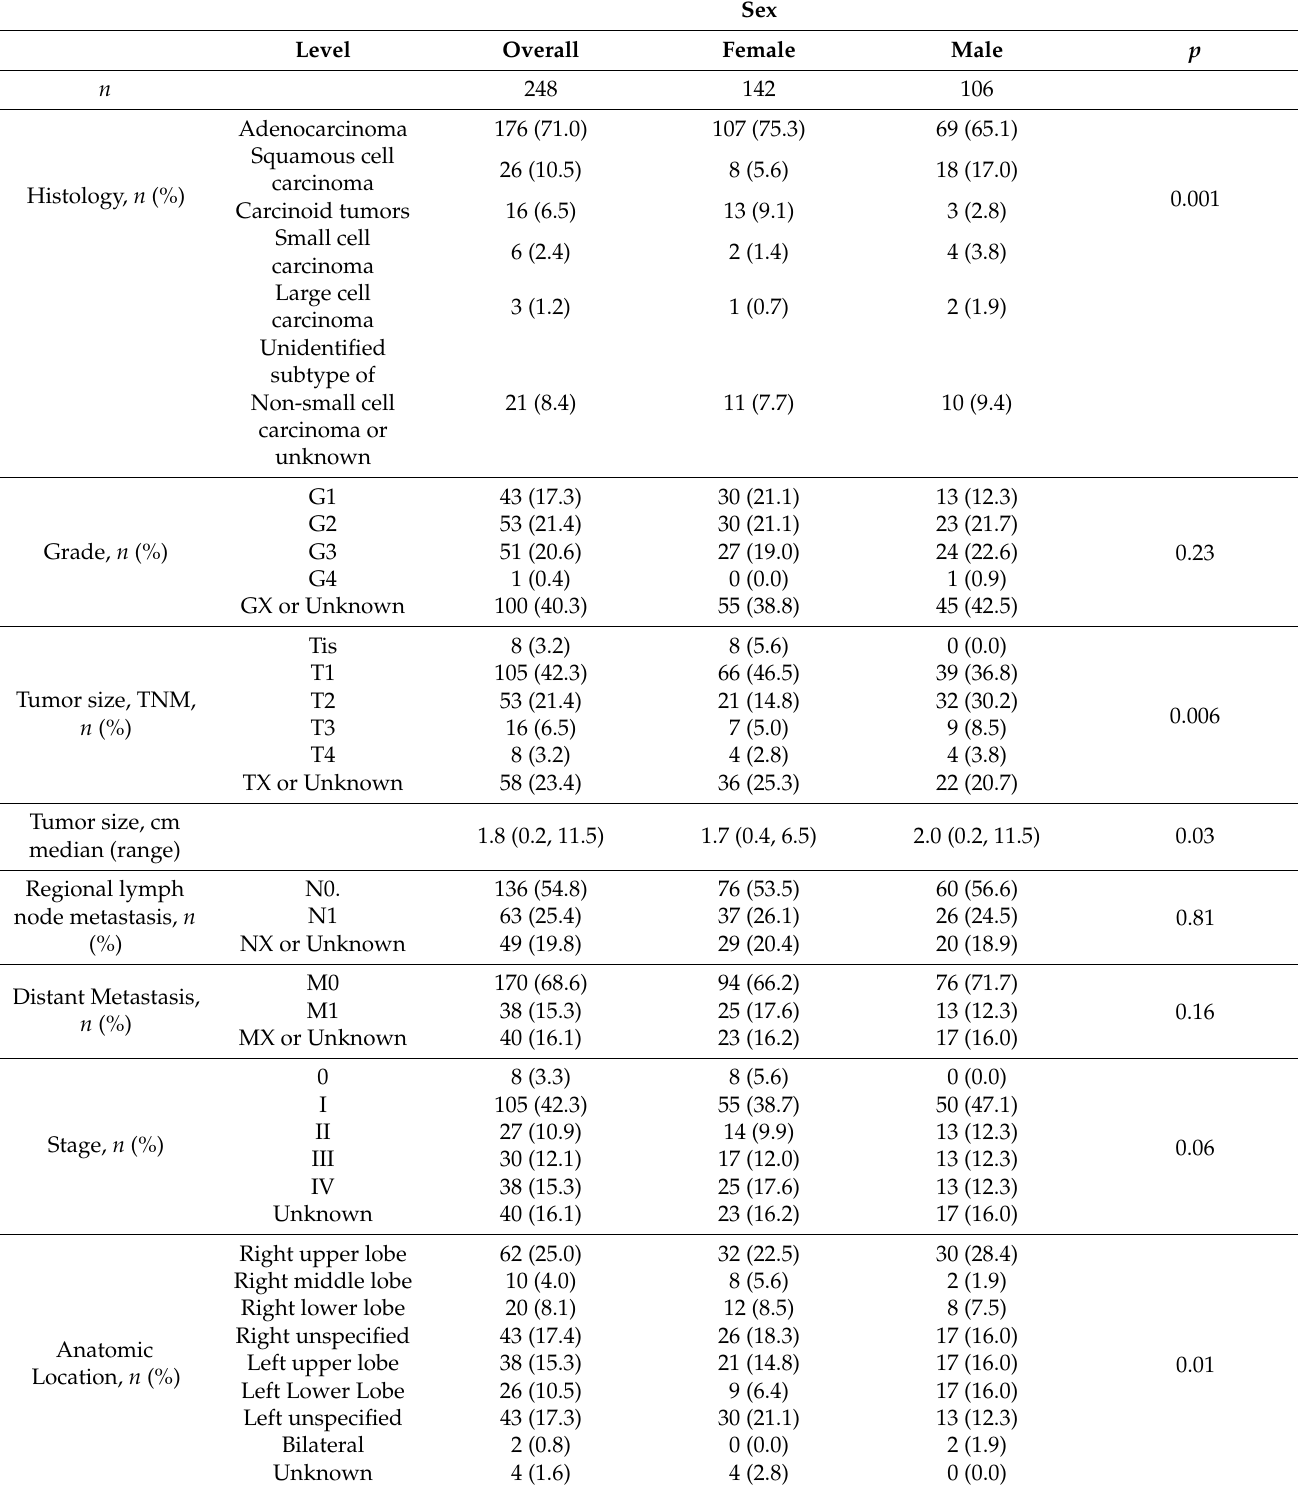
Table 4. Characteristics of lung cancers with gender classification in the WTC Environmental Health